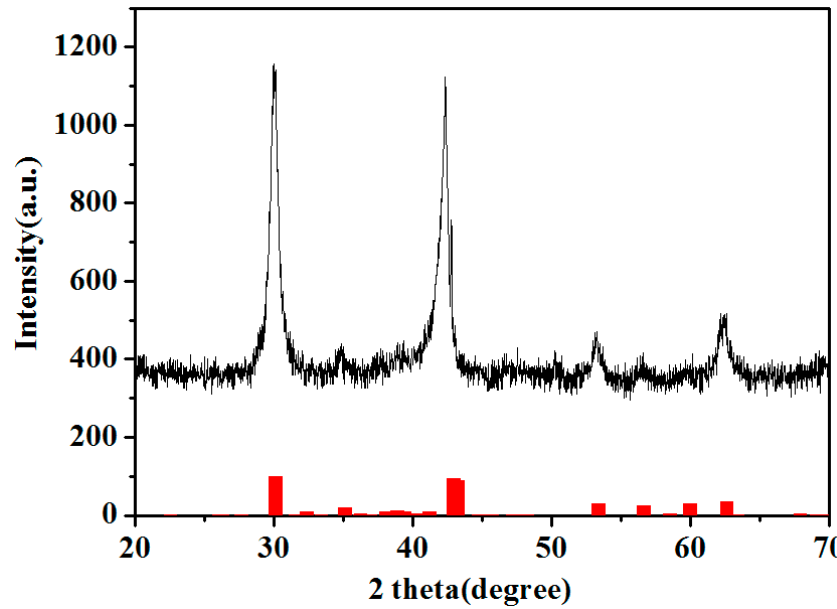
Figure 1. The XRD patterns of the Cel-CS electrode.